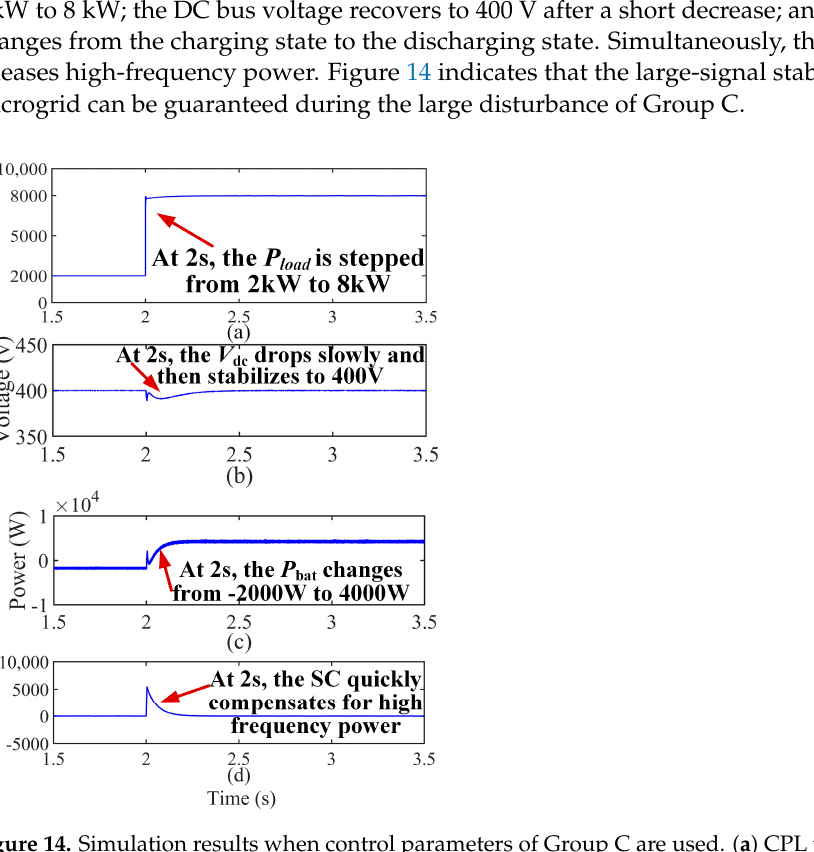
Figure 14. Simulation results when control parameters of Group C are used. ( a ) CPL power, ( b ) DC bus voltage, ( c ) battery power and ( d ) SC power.